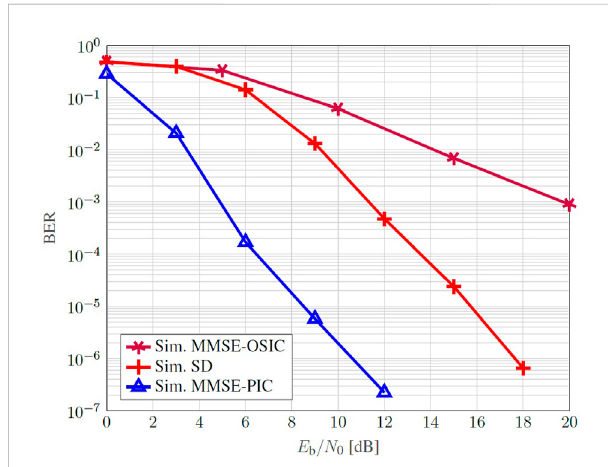
FIGURE 12 BERMonteCarlosimulationofacoded16-QAM employing a4× 4 SM-MIMO-OFDM in time-varying and frequency selective channel.